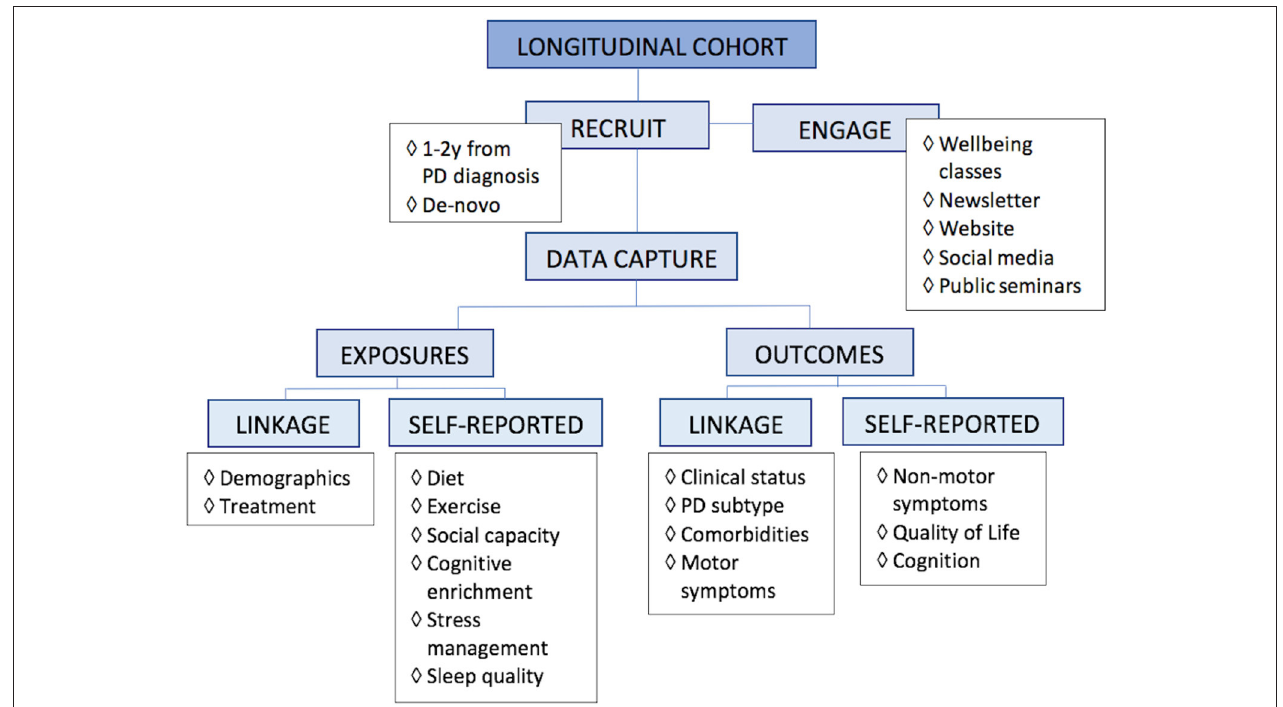
FIGURE 2 | Proposed research design for lifestyle. For research into multimodal lifestyle factors that impact Parkinson’s disease, we propose a longitudinal study of an enriched population, capturing data via linkage, and self-reported online